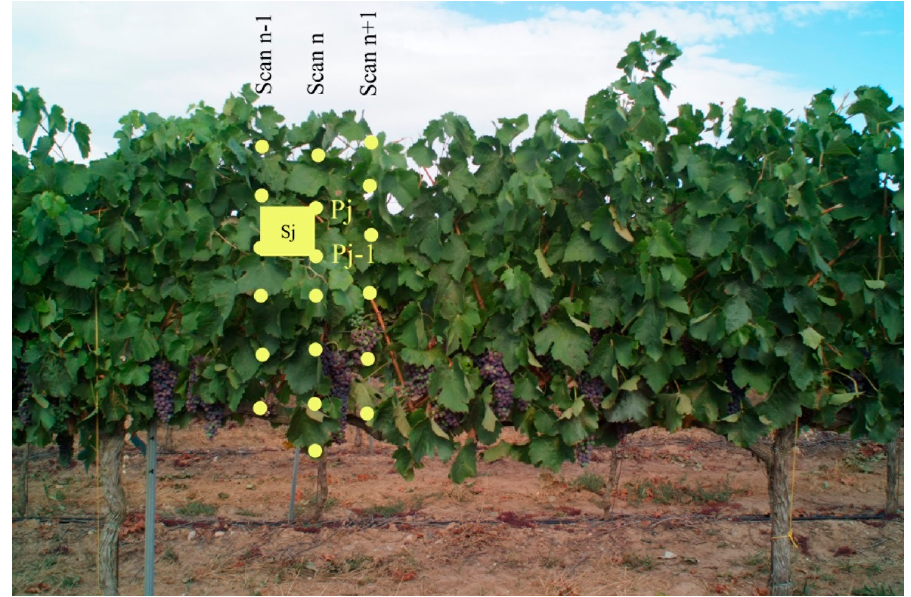
Figure 4. Intercepted points generated by consecutive scans and specific pixelated area (Sj) assigned to one of interception points (Pj).